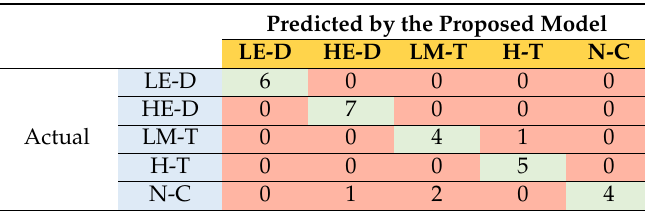
Table 11. Confusion matrix of the diagnostic